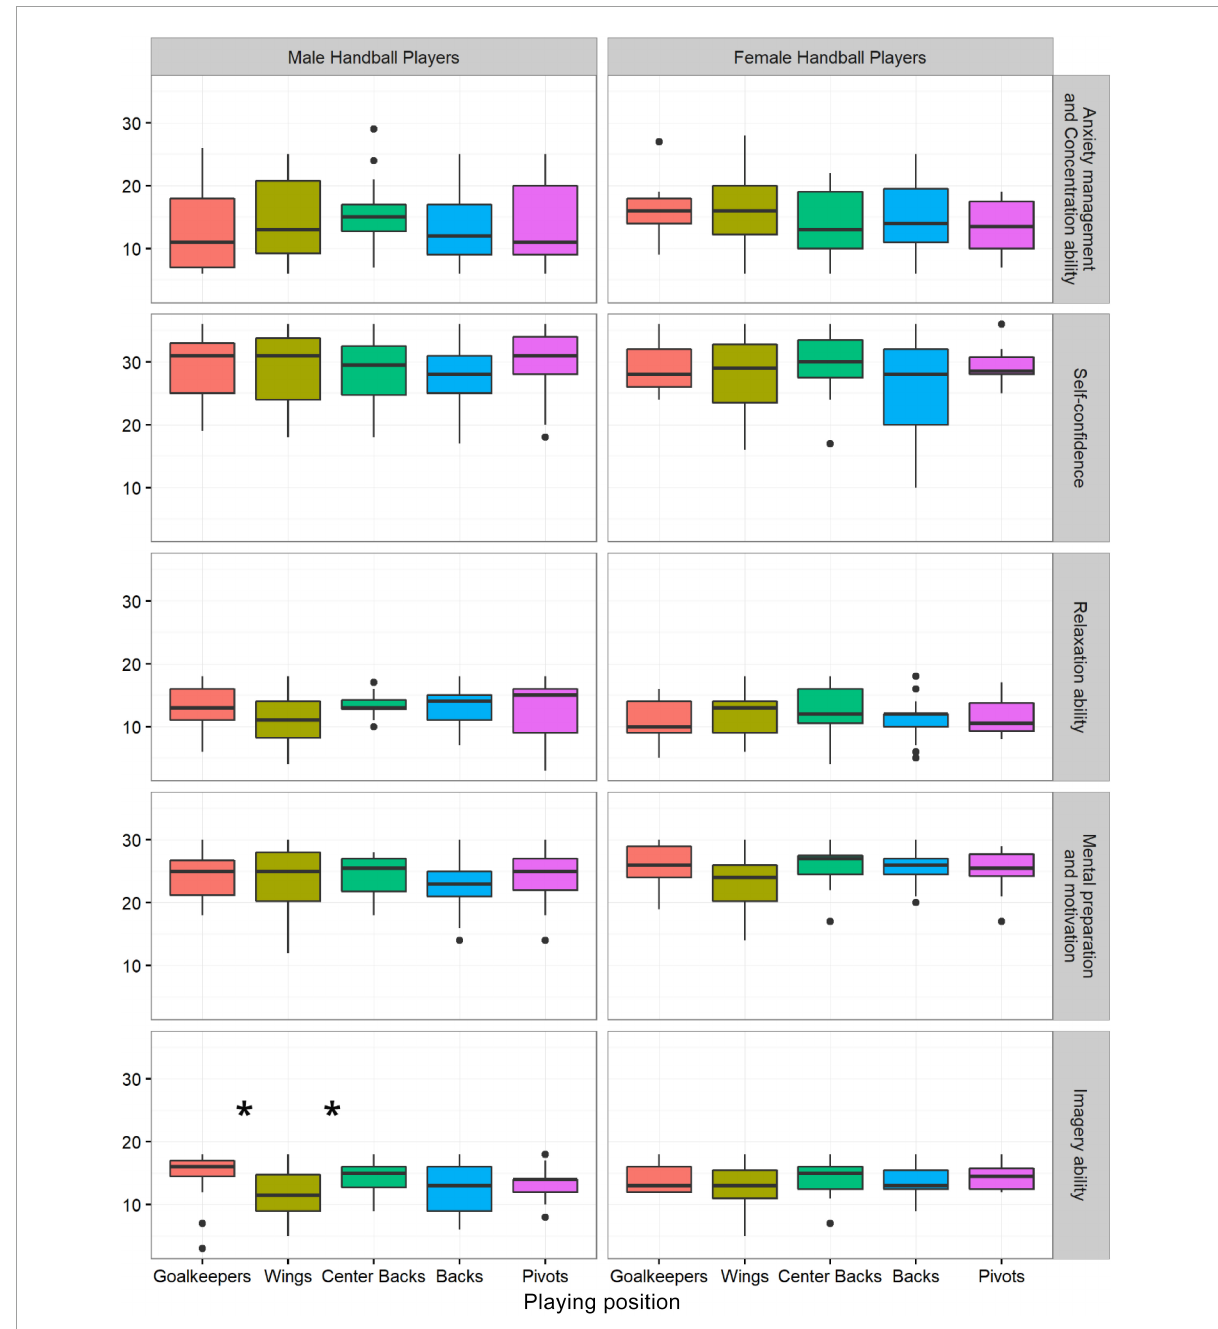
FIGURE1 Differences in playing positions in the obtained factors. Data shows medians and interquartile ranges: * p ≤ 0.05.